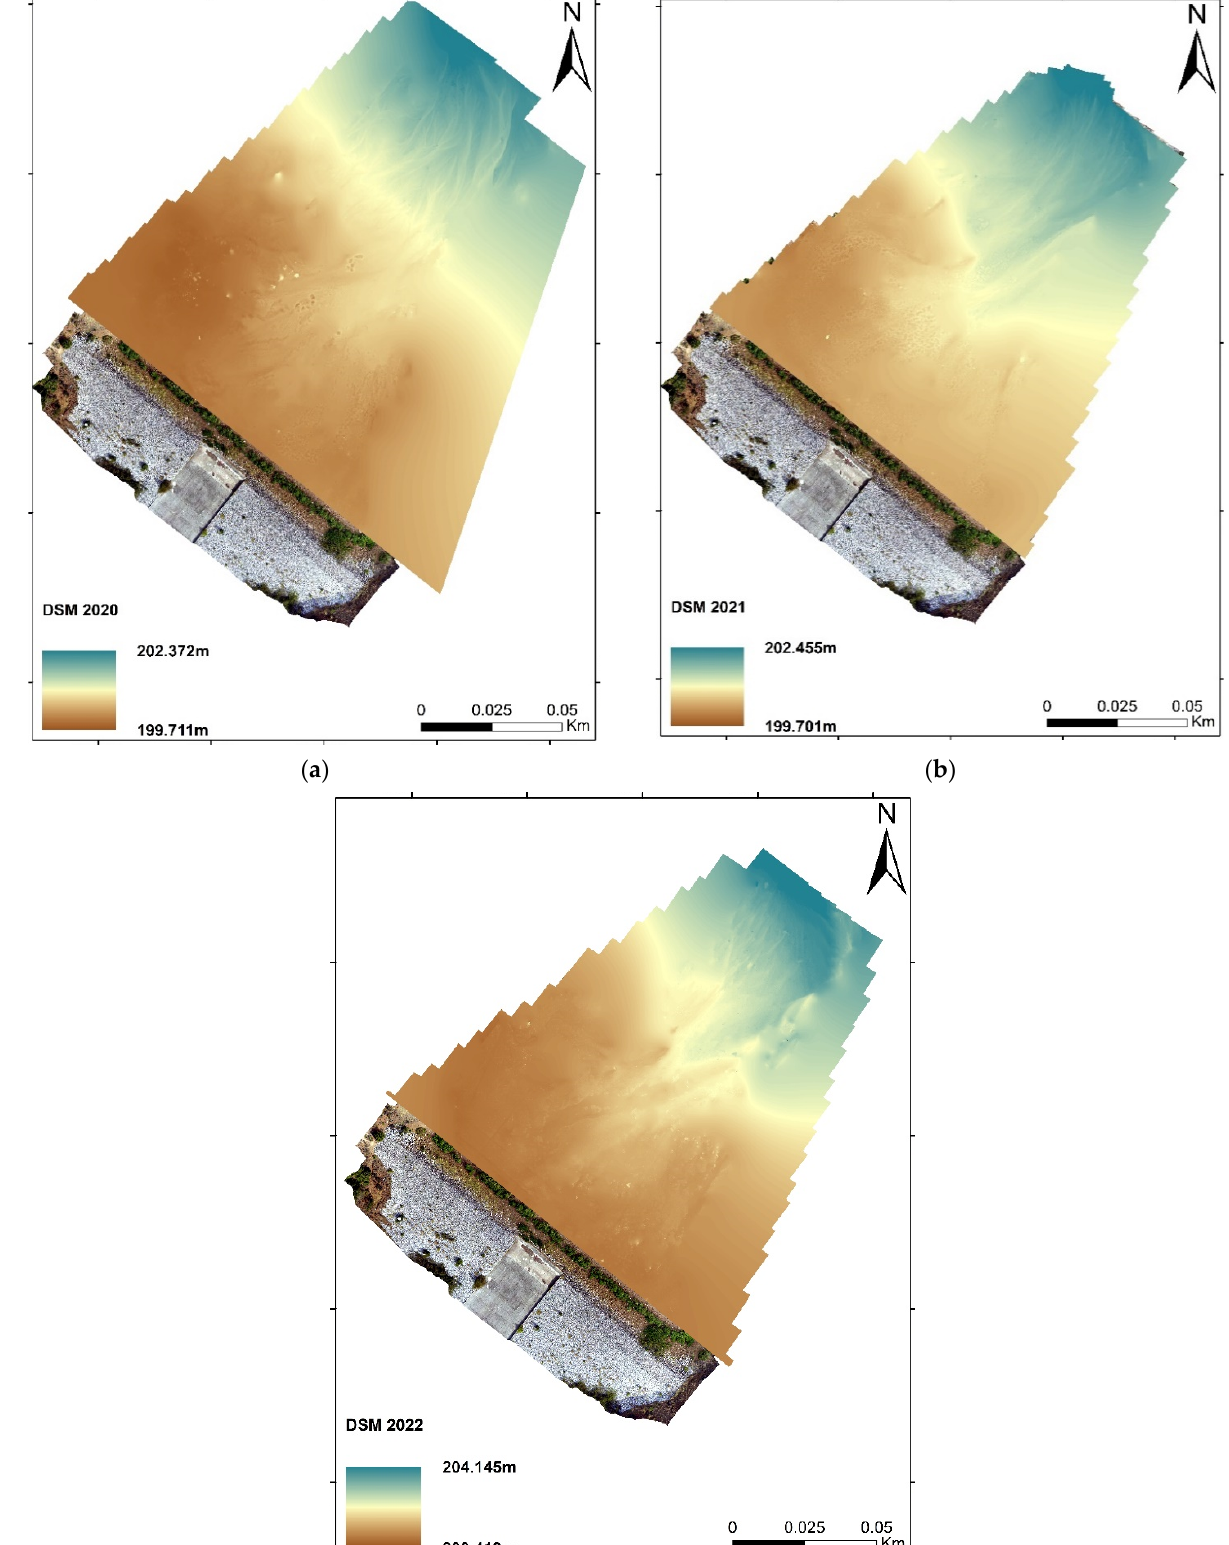
Figure 10. DSM (0.02 × 0.02 m pixel size) interpolated for error evaluation. ( a ) 28 August 2020; ( b ) 16 September 2021; ( c ) 13 October 2022.